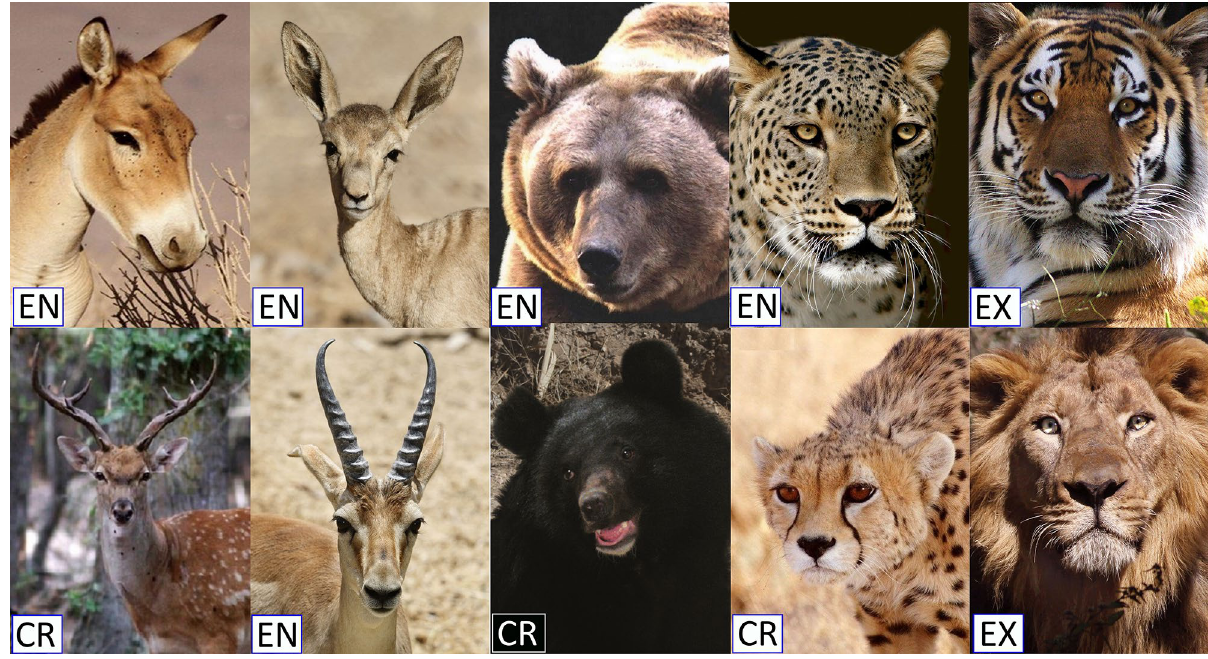
Figure 1. Photographic examples of threatened large mammals. Top row left to right: Onager or Persian wild ass ( Equus hemionus onager ), Goitered or Persian gazelle ( Gazella subgutturosa ), brown bear ( Ursus arctos ), Persian leopard ( Panthera pardus saxicolor ), and Caspian tiger ( Panthera tigris virgata ). Bottom row left to right: Persian fallow deer ( Dama mesopotamica ), Chinkara or Indian gazelle ( Gazella bennettii ), Asiatic black bear ( Ursus thibetauns thibetauns ), Asiatic cheetah ( Acynonix jubatus venaticus ), and Persian lion ( Panthera leo persica ). The national endangerment classification for each species (adapted from Yusefi et al. 13 ) noted on the image. Status categories are endangered (EN), critically endangered (CR) and extinct (EX). Photo credits: Fariborz